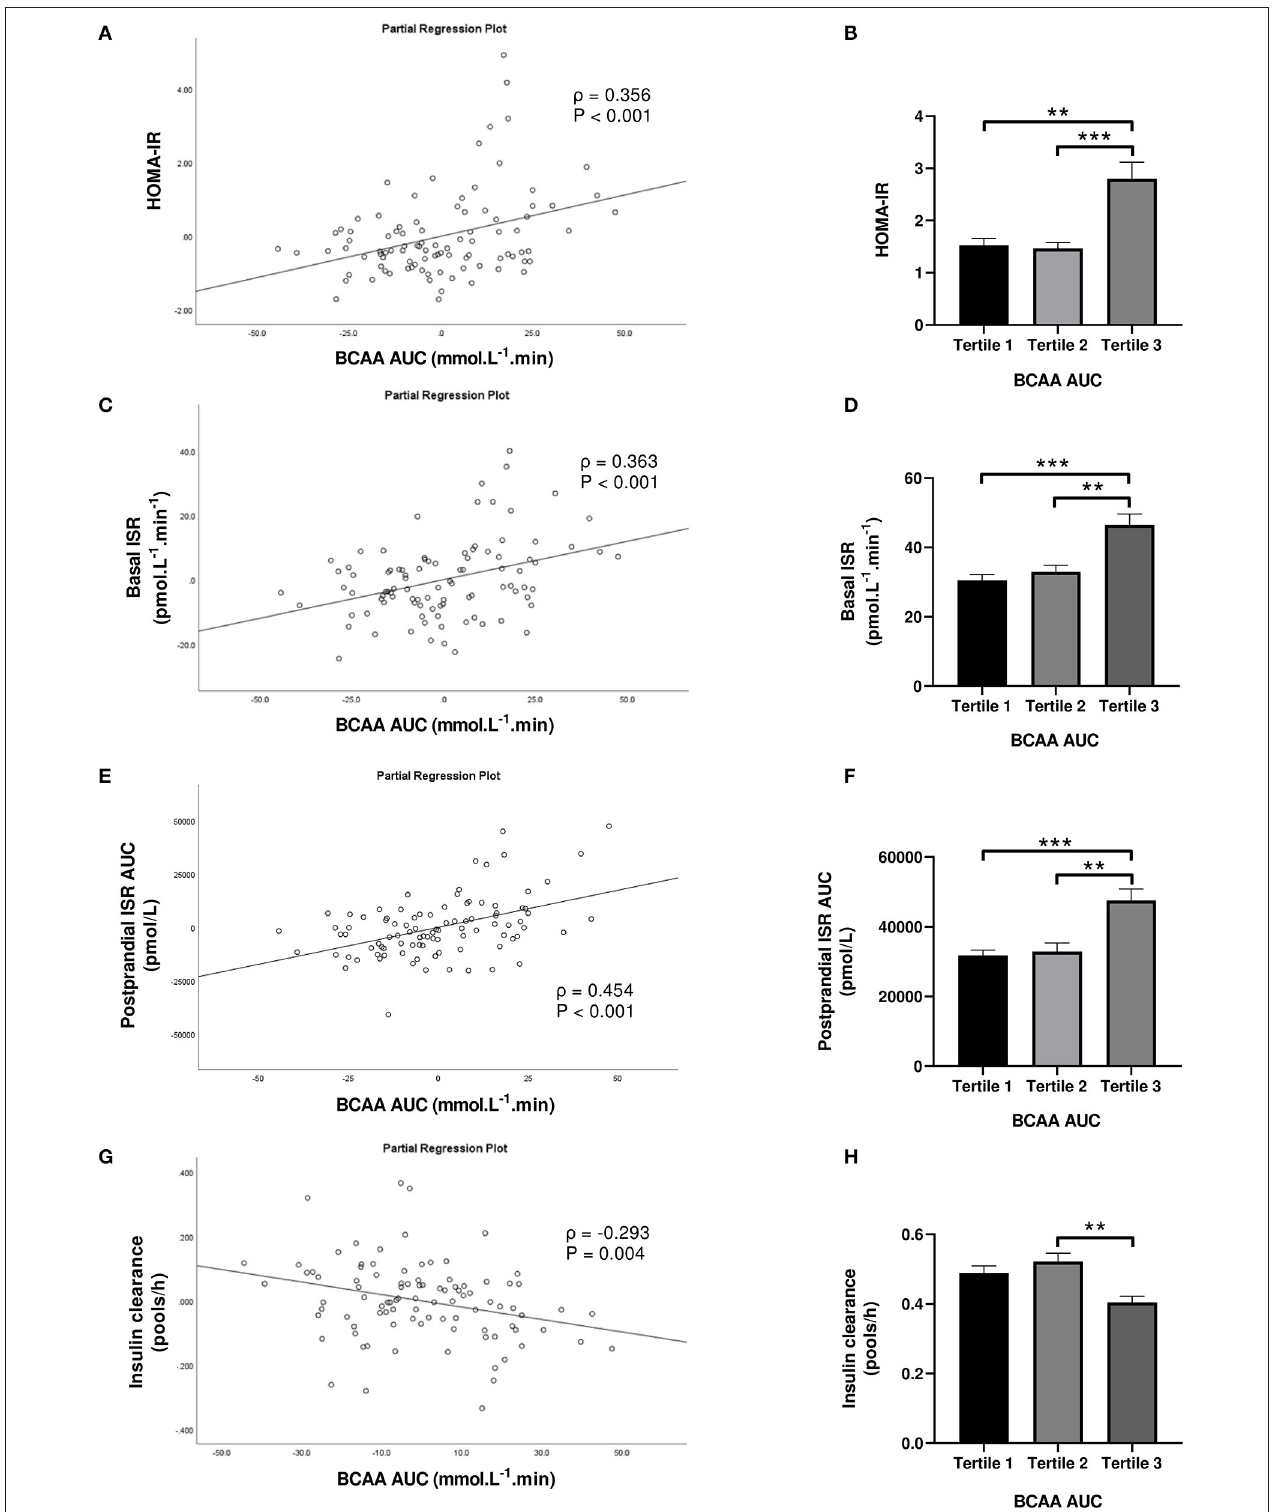
FIGURE 5 | Homeostasis Model Assessment of Insulin Resistance (HOMA-IR; A,B ), basal insulin secretion rate (ISR; C,D ), total postprandial ISR area under the curve (AUC; E,F ) and insulin clearance (G,H) in relation to postprandial BCAA AUC (left) and in subjects stratified to tertiles of postprandial BCAA AUC (right). Data are mean ± SEM; n = 31–32 per group. Continuous analyses are depicted as partial correlation plots and differences among tertiles are determined by one-way ANOVA. All analyses have been adjusted for sex and BMI. Corresponding values are significantly different between groups (Šidák-corrected): ** P < 0.01, *** P < 0.001.